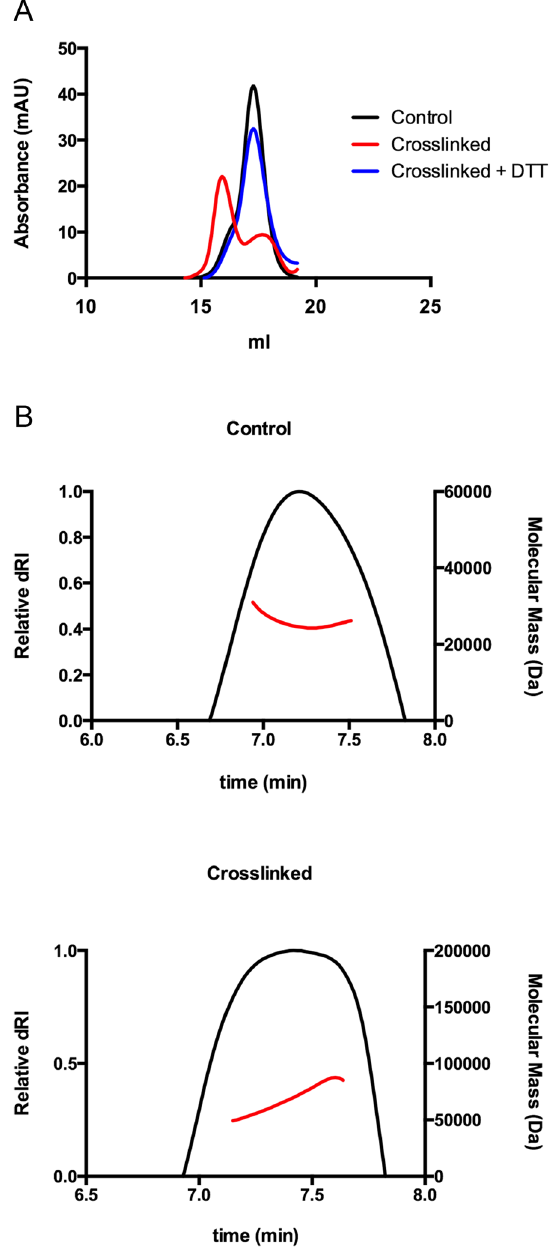
Figure 4. Specific Crosslinking and multi-angle light scattering analysis of TAZ-TEAD complex. ( A ) Analytical gel filtration shows that crosslinking (red) causes the TAZ-TEAD complex to elute earlier than control (without crosslinking, black), indicating an increase in molecular weight. Reversal of crosslinking by addition of DTT (blue) reverts the size of the protein complex to that of the control. ( B ) Differential refractive index of the control (top) and crosslinked (bottom) protein complexes plotted as a function of time. The weight average molecular weight of the protein complex, calculated from light-scattering measurements, is shown as a red continuous